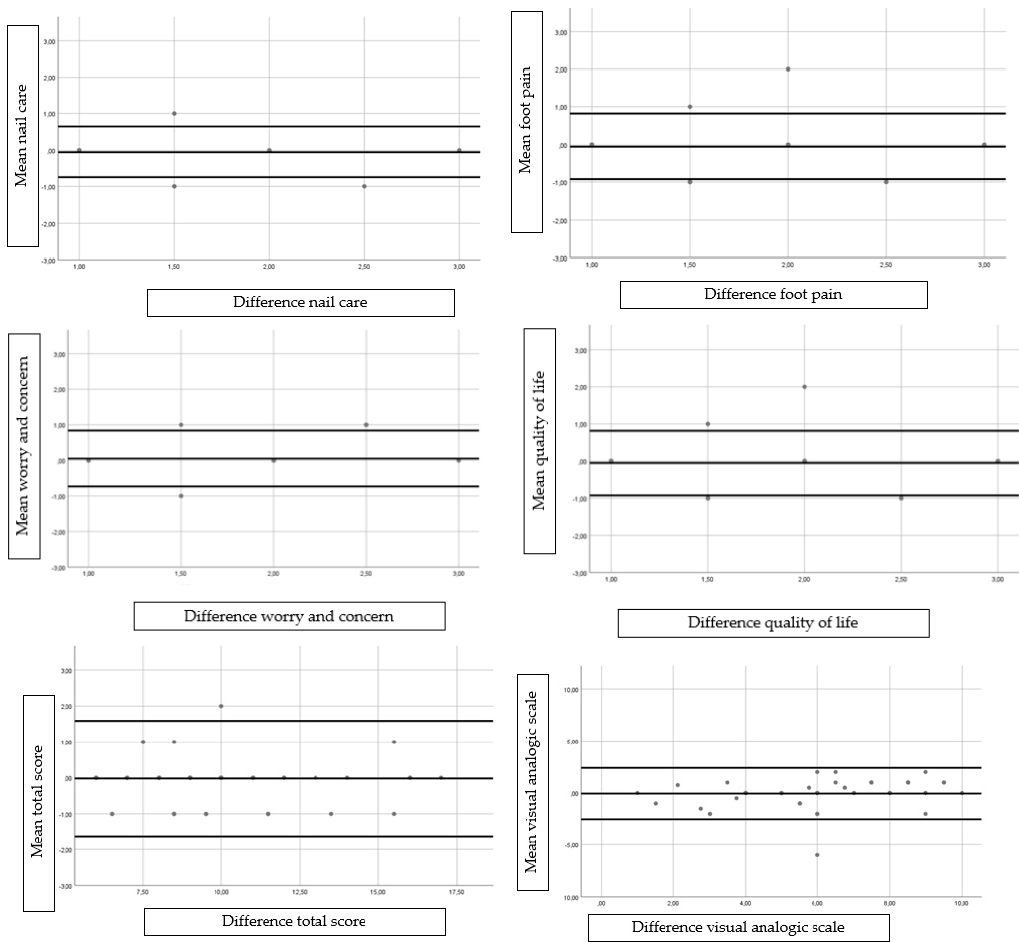
Figure 2. Bland–Altman plot showing the agreement between test and retest for the individual subscales and the total score.